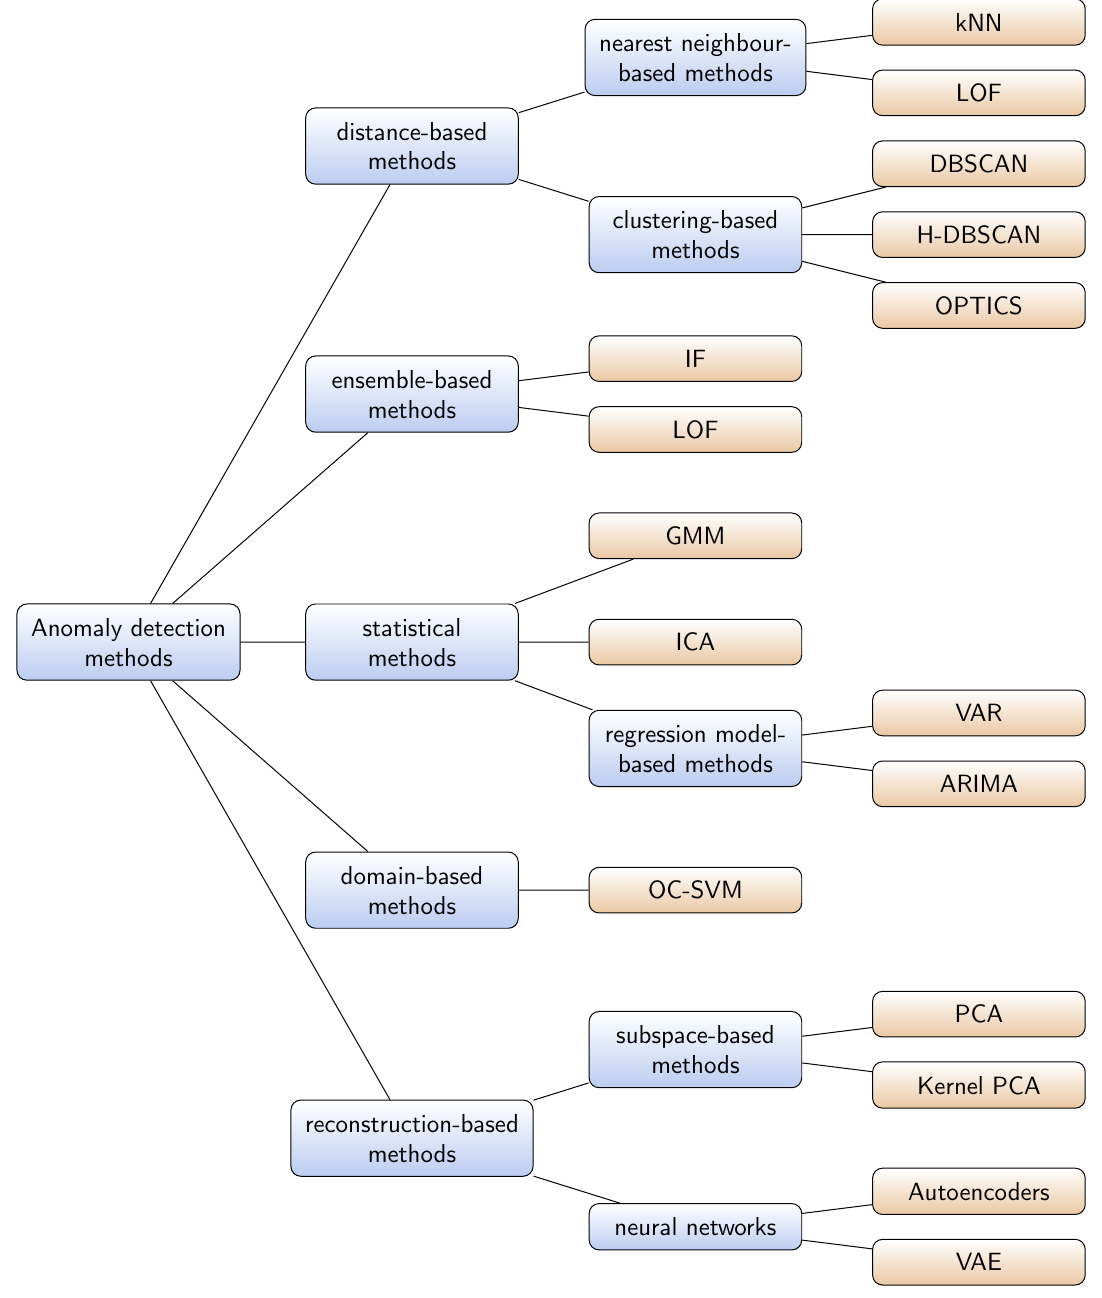
Figure 1. Taxonomy of classical anomaly detection